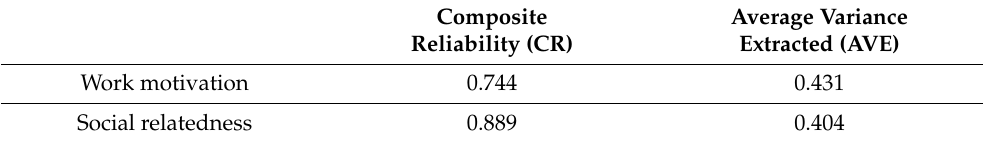
Table 3. Convergent validity.